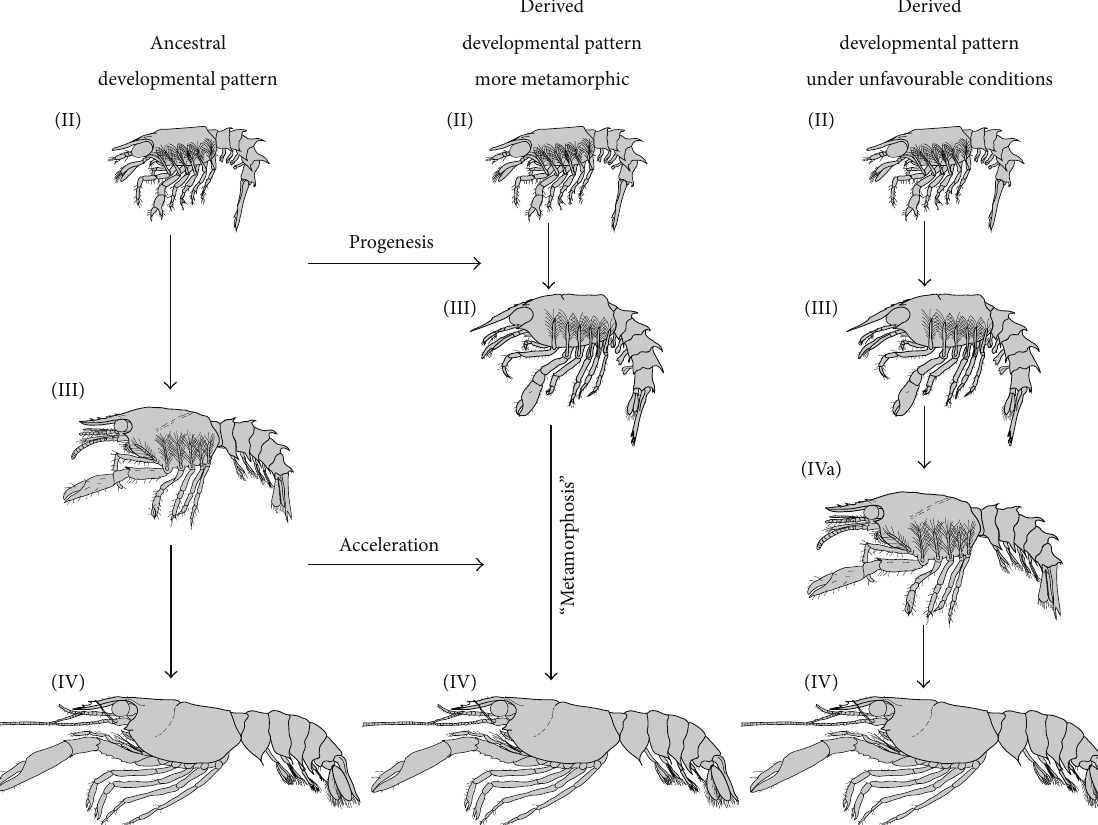
Figure 12: Evolutionary scenario for the changes in ontogeny in Homarus . Presumed ancestral developmental pattern as seen in H. gammarus (and hybrids of H. gammarus and H. americanus ), with rather gradual developmental steps. Derived developmental pattern as seen in H. americanus; the stage (III) is less far developed than that in the ancestral pattern. Hence the developmental step from (II) to (III) is “shorter” and leads to a more juvenile appearing larva (III) → paedomorphosis. The larva was simply “stopped,” as it is also slightly smaller → progenesis. The developmental step from (III) to (IV) on the other hand is now more pronounced, it appears more metamorphic, and this moult is often interpreted as a “metamorphosis.” This type of heterochronic shift is a peramorphosis, more precise, and it represents a case of acceleration. All drawings modified by Charmantier et al. [23] and Charmantier and Aiken